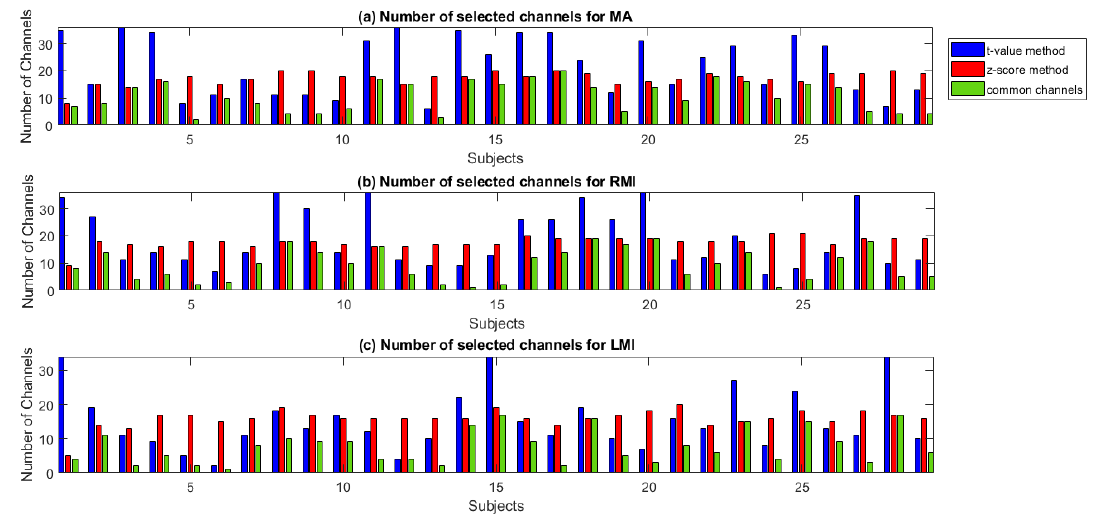
Figure 8. Total number of channels selected by t -value, z-score method, and common channels for ( a ) MA, ( b ) RMI, and ( c ) RMI task.